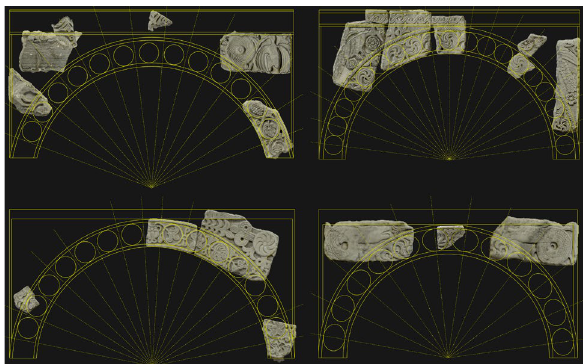
Figure 6. Geometrical rules in the arcades of the ciborium